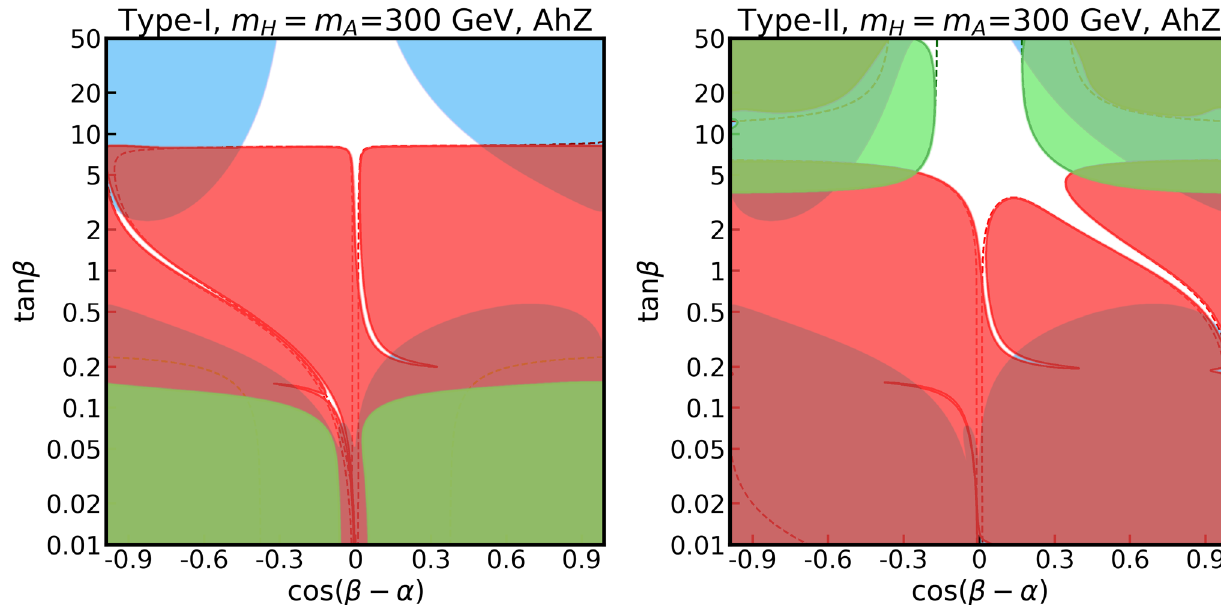
Fig. 3 Regions in the cos (β − α) -tan β plane excluded by experimen- tal results in the A → Zh channel in the Type-I (left panel) and Type-II (right panel) 2HDM. We have assumed degenerate heavy Higgs masses of 300 GeV. The dashed lines in the figures reproduce the tree-level constraints, while the green and red regions are one-loop level results. The green ones are assumed to be excluded by the b -associated pro-